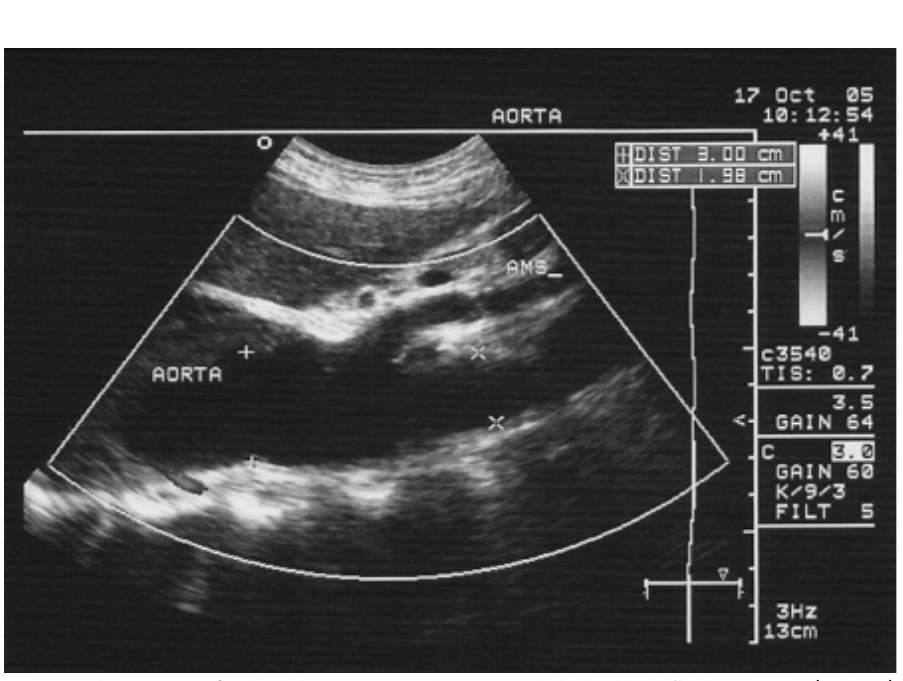
Fig. 2 - Ultra-sonografia de abdome, mostrando continuidade da dilatação da aorta torácica até artéria mesentérica